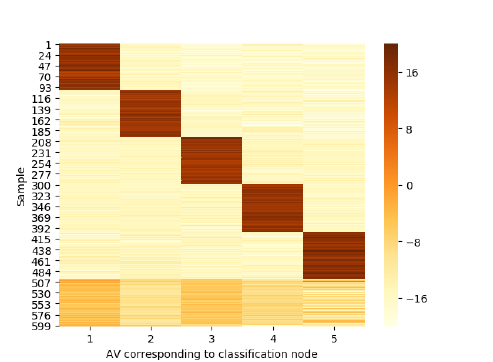
Figure 6. Visualization of AV distribution of the penultimate layer.